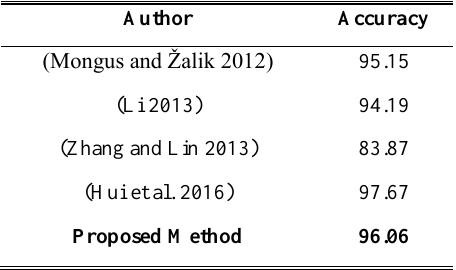
Table4. Accuracy of sample_61 in ISPRS dataset reported by novel